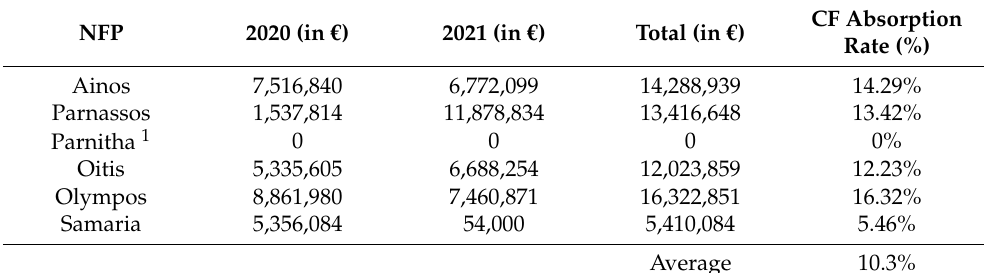
Table 2. Number of assigned projects and payments for each NFP being examined per year and the CF absorption rate. NFP 2020 (in € ) 2021 (in € ) Total (in € )